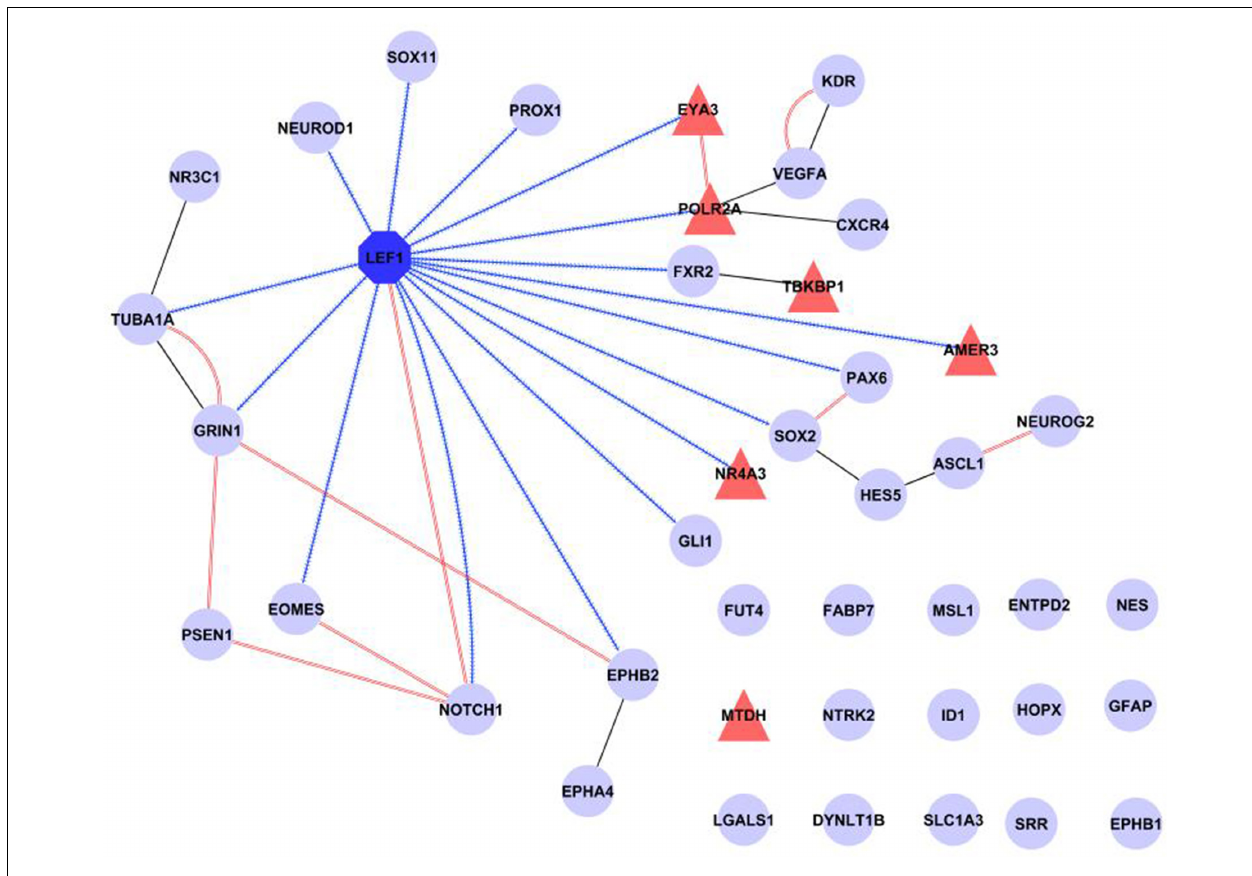
FIGURE 5 | Summary of known interactions shows a central role for Lef1. The transcription factor Lef1 (dark blue octagon) is central in a network comprised of our six candidate genes (red triangles) and 35 genes expressed in Nestin positive cells (pale blue circles). Transcription factor